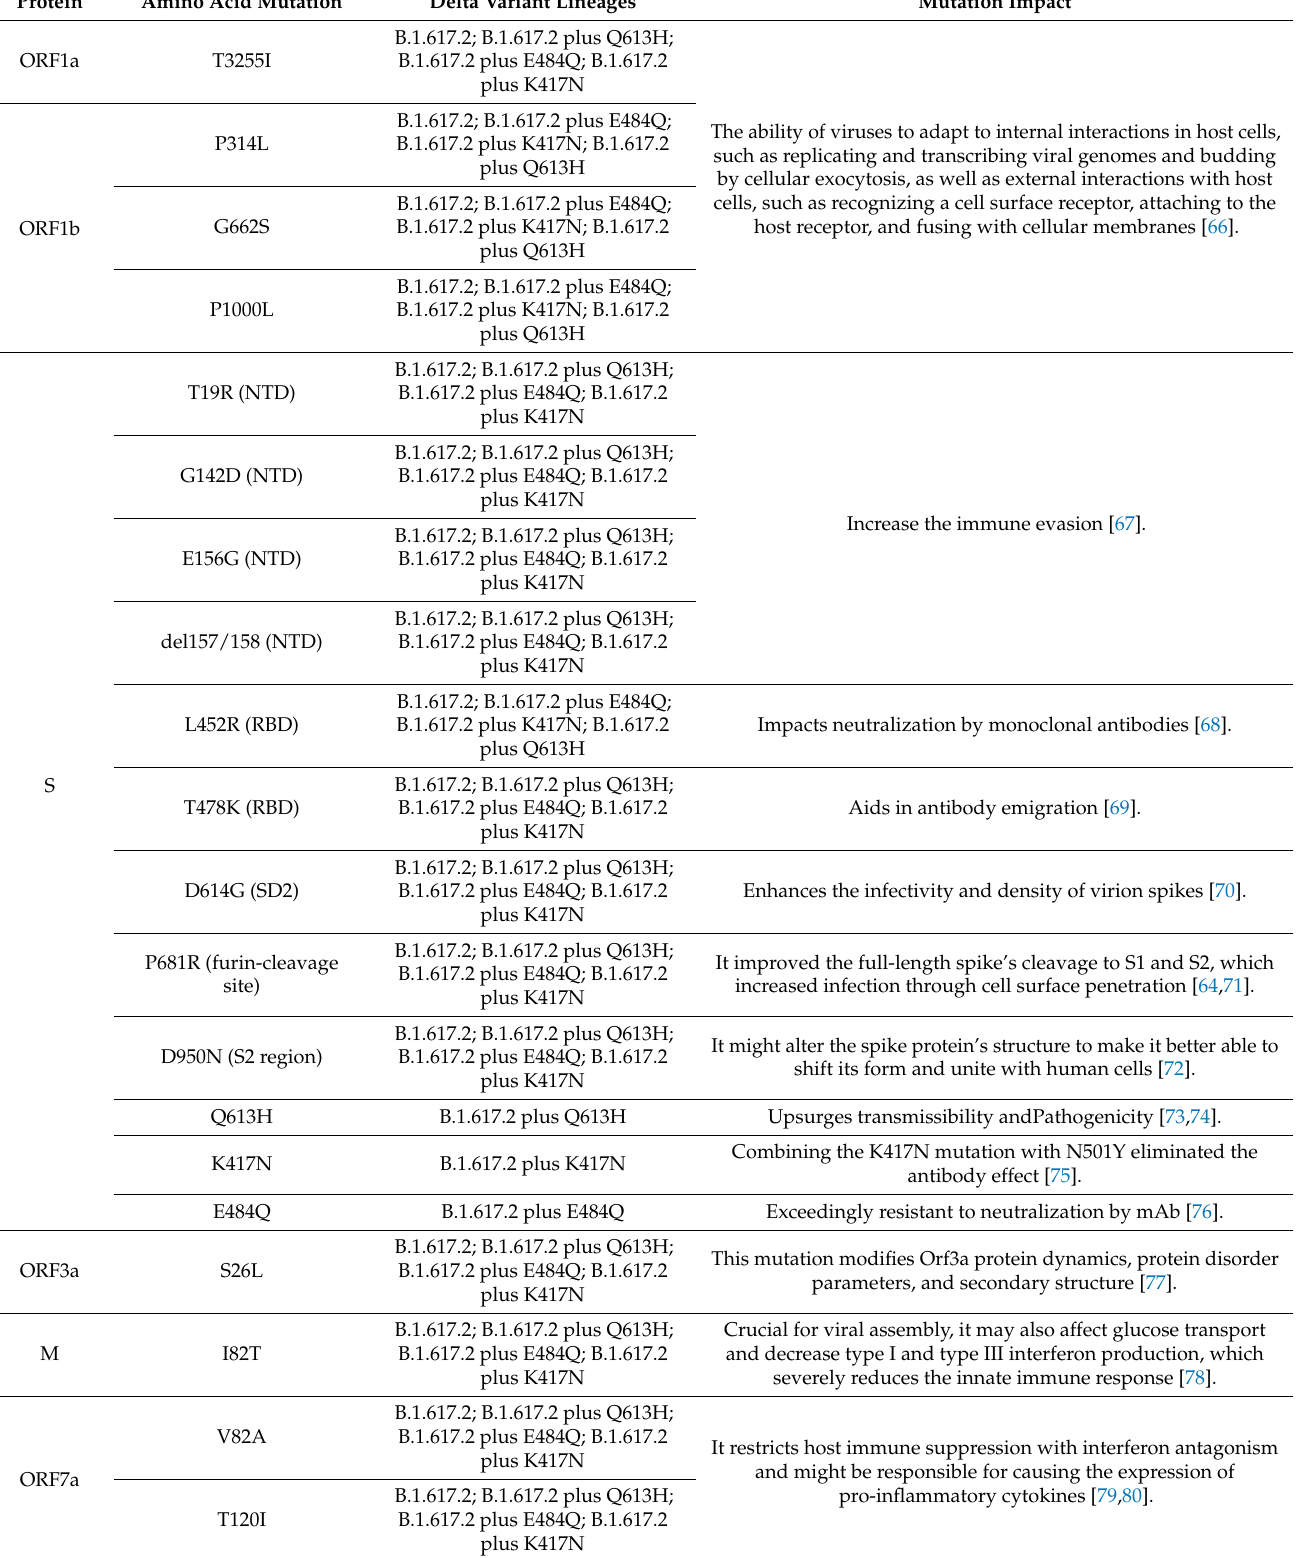
Table 1. Characteristic mutations of Delta variants